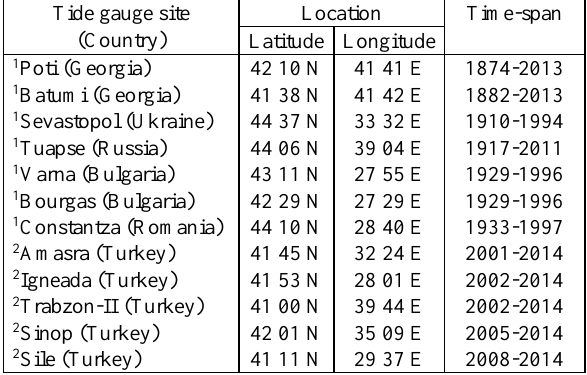
Table 1. Tide gauge sites along the Black Sea coast ( 1 and 2 refer the sites from PSMSL and TUDES respectively)